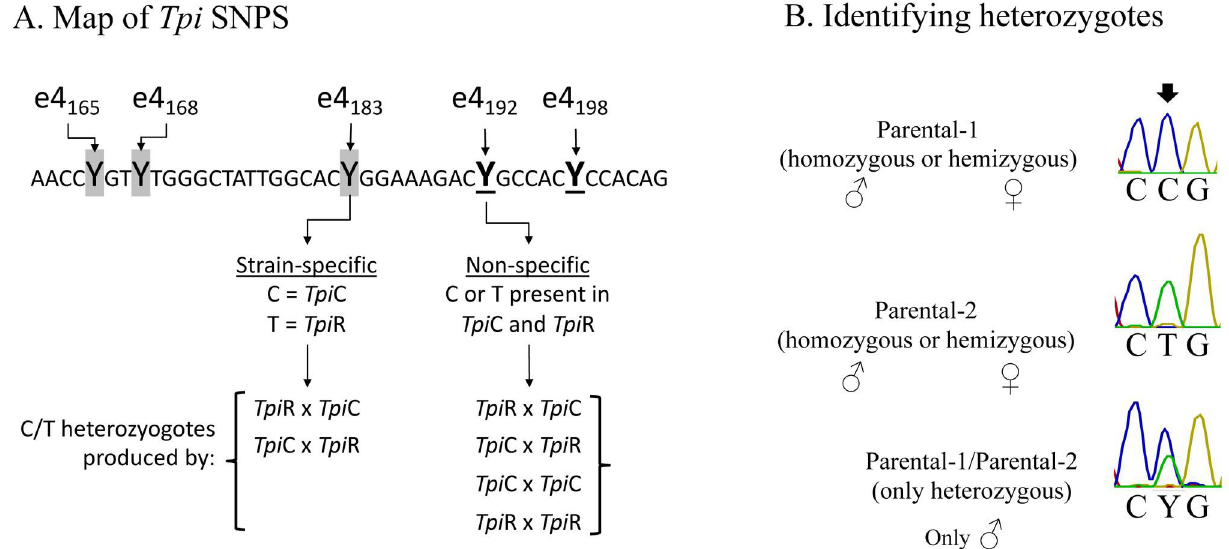
Fig 2. Map of selected Tpi SNPs that differ in strain-specificity including a list of the crosses that will produce heterozygotes at these sites and a description of the method to identify heterozygotes. (A) DNA sequence of the segment of the fourth exon of the coding region containing three strain- specific sites (shaded) and two non-specific sites (underlined and bold). All SNPs are associated with a C or T (designated Y by IUPAC convention). Below are the types of crosses that can produce heterozygotes at e4 183 and e4 192 . (B) Example of DNA sequencing chromatographs diagnostic of the two parental alleles as present as a hemizygote or homozygote, and the chromatograph representing the heterozygous combination that shows an overlap of the parental curves.